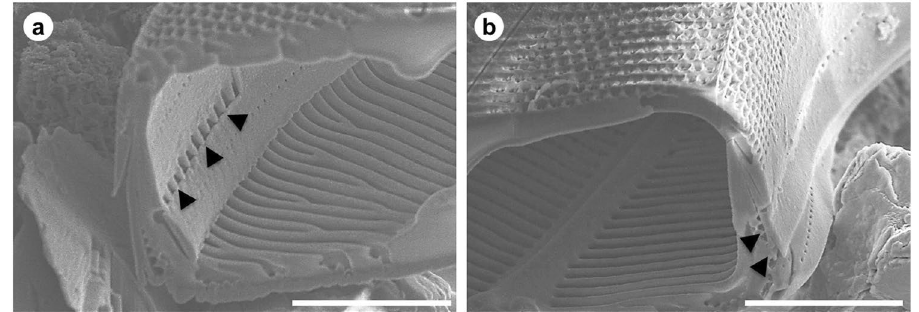
Figure 5. SEM image of an FIB cross-section through the D. geminata frustule, showing an overlapping epivalve and interlocking of adjacent girdle bands (marked with arrows): ( a ) left side, ( b ) right side. Scale bars: 10 µ m.